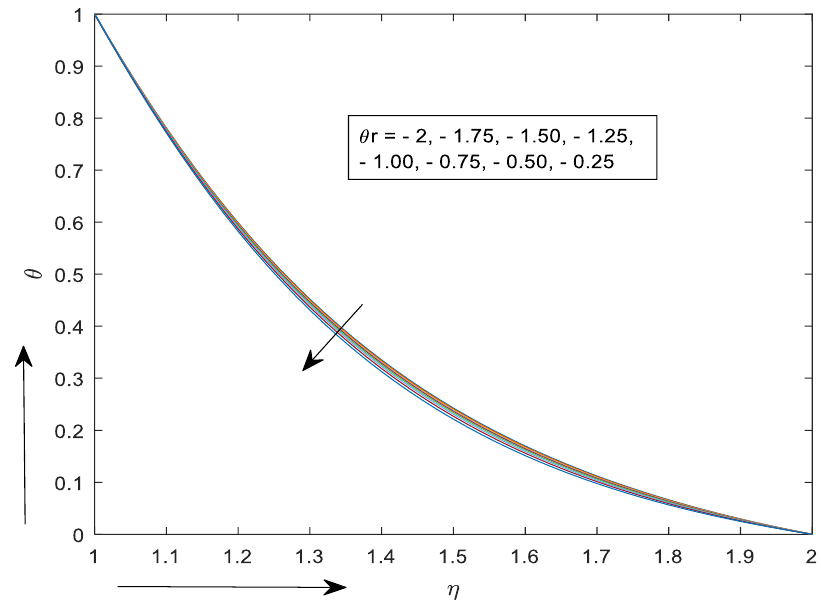
Figure 7. Temperature profile for different values of 𝜃